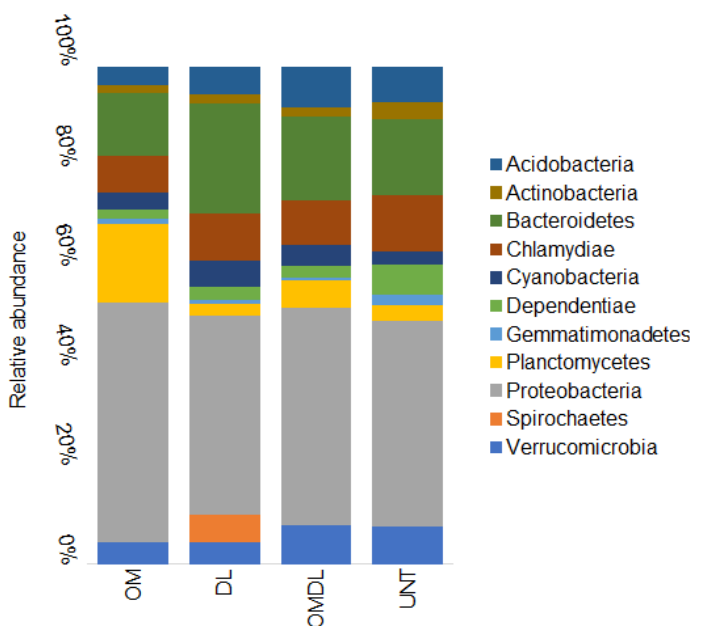
Figure 2. Prokaryotic phyla with relative abundance ≥ 1% detected in at least one treatment replicate of the total sequences revealed by the analysis of the 16S rRNA gene using high throughput sequencing. No significant di ff erences among treatments were observed at the phylum level. Di ff erences were observed among the leachates from di ff erent treatments in the prokaryotic OTUs at the genus level with an abundance of ≥ 1% of the total sequences and detected in at least one replicate per treatment (Figure